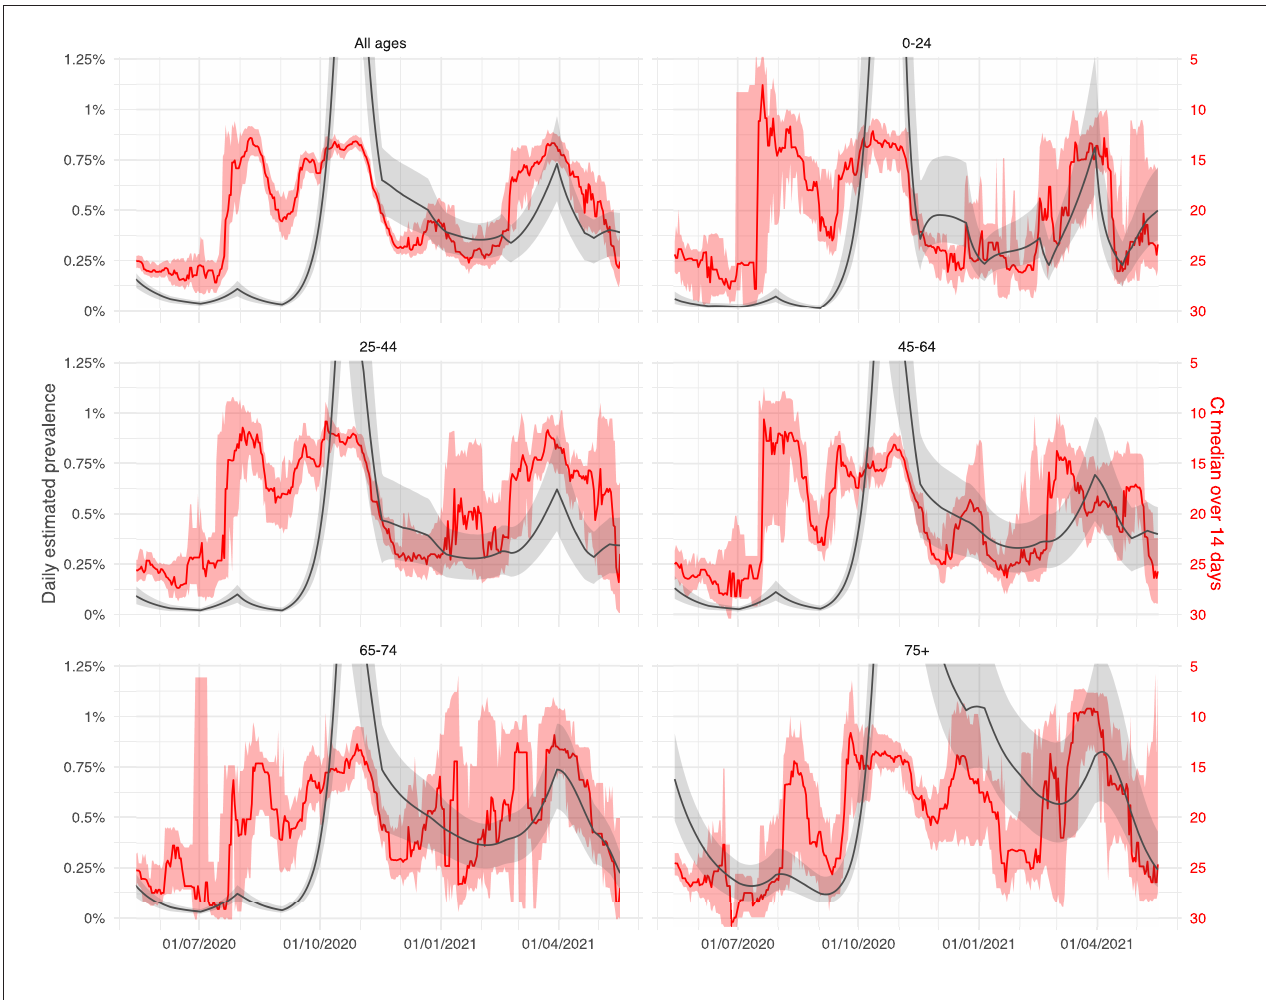
FIGURE 5 | Ct evolution by age classes with comparison to the estimated prevalence: evolution of the daily 14-day median Ct values obtained using the Abbott RealTime SARS-CoV-2 assay from April 1, 2020, to May 15, 2021 (LHUB-ULB, Brussels region, Belgium). Reddish areas surrounding solid red curves indicate the 95% confidence interval (CI) obtained by bootstrapping method associated with daily estimates of median Ct values. Those curves are superimposed on the daily prevalence of COVID-19 infected people (proportion of infected vs. Belgian demographic data) as estimated by the age-structured extended SEIR-type mathematical model. Solid grey curves indicate the 95% CI obtained by Bayesian analysis. Full data figure in Supplementary Material